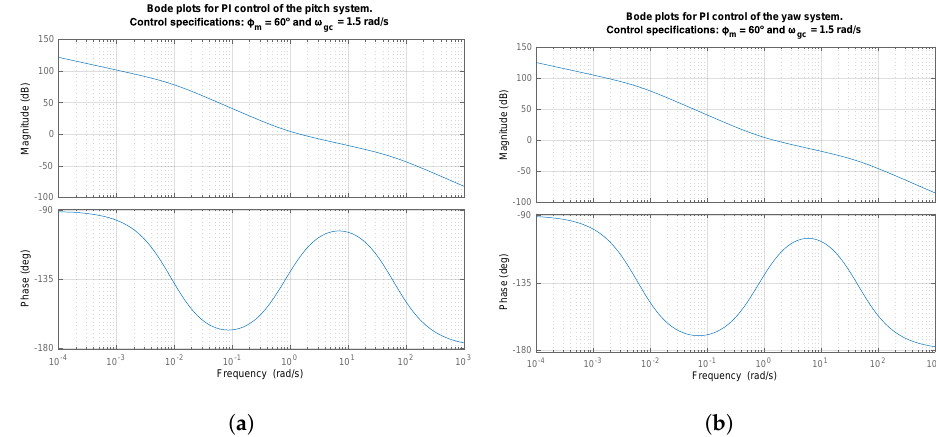
Figure 7. Bode plots of the open loop systems with the resulting PI controllers. Control specifications: φ m = 60 ◦ and ω gc = 1.5 rad/s. ( a ) Bode plots of the open loop system with the PI controller corresponding to the pitch system. ( b ) Bode plots of the open loop system with the PI controller corresponding to the yaw system.